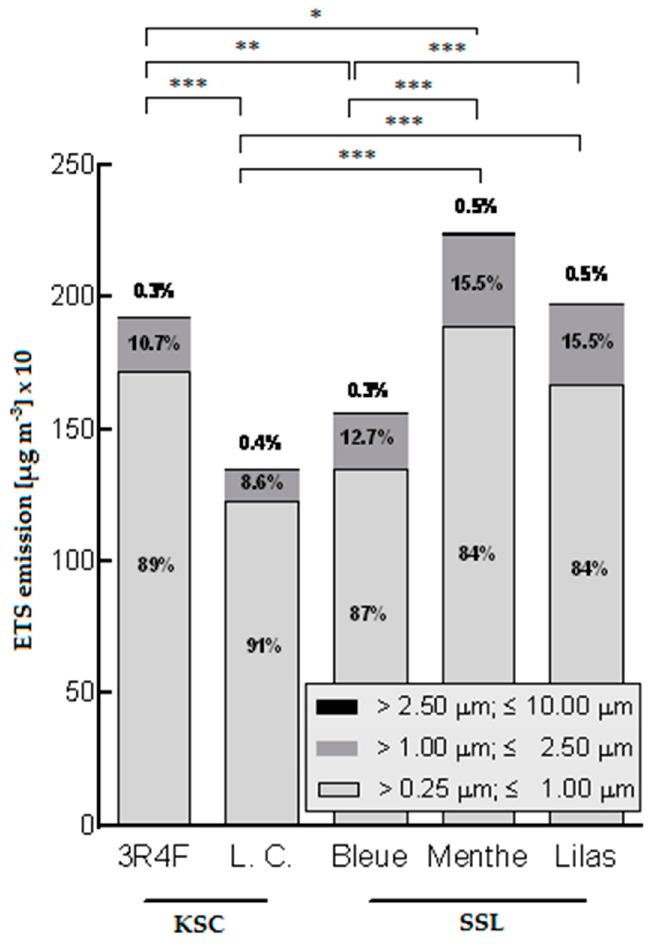
Figure 2. Distribution pattern of PM emissions in CMSS and comparison of KSC 3R4F (reference), KSC Vogue La Cigarette (L.C.), and SSL cigarettes (Bleue, Menthe, Lilas). Stars represent significance level of post hoc test with * p < 0.05, ** p < 0.01, and *** p < 0.001. KSC—king size cigarette, SSL—super slim.